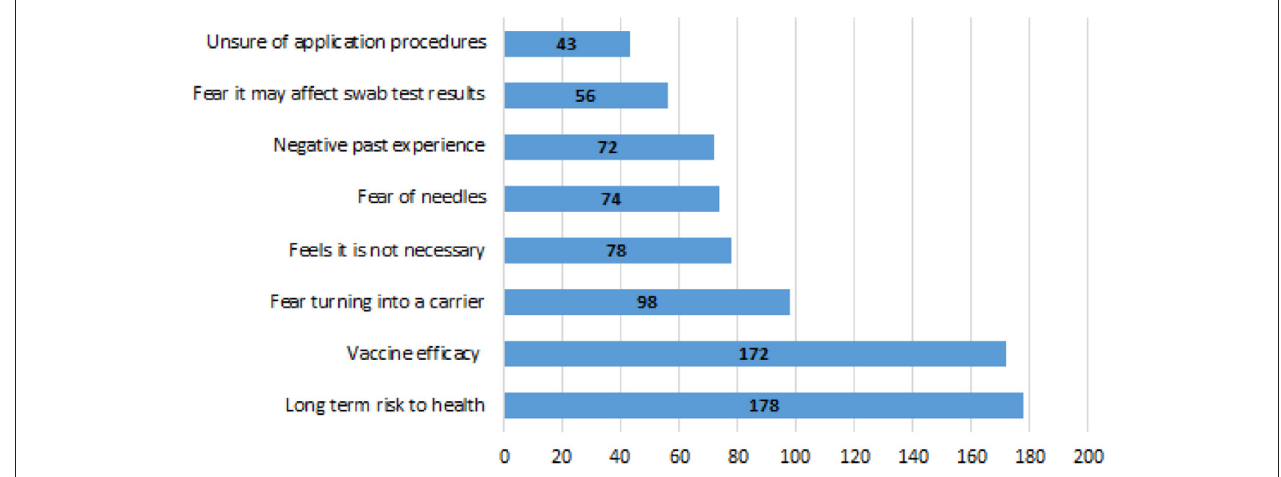
FIGURE 1 | Deterring factors to vaccination.